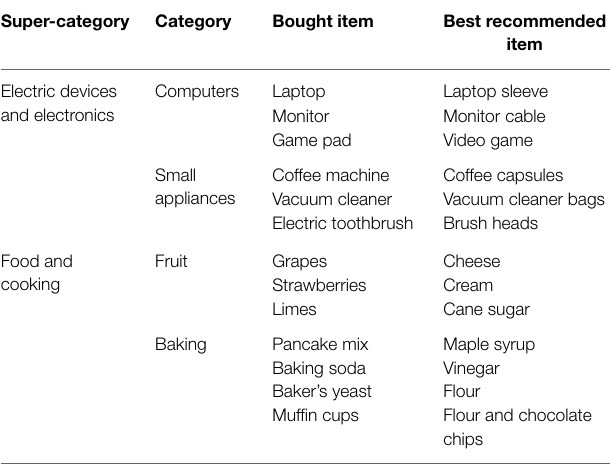
TABLE 1 | Recommender system example .